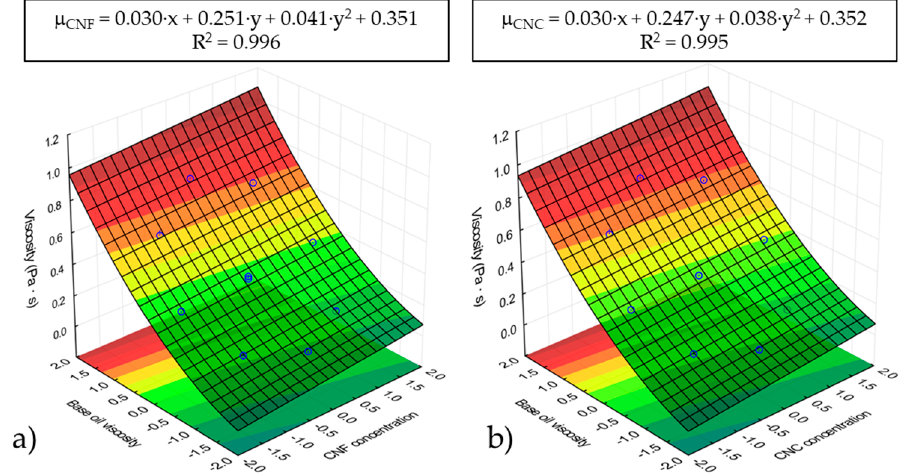
Figure 2. RSM analysis of viscosity values at 25 ° C for ( a ) CNF-based ecolubricants and ( b ) CNC- based ecolubricants.